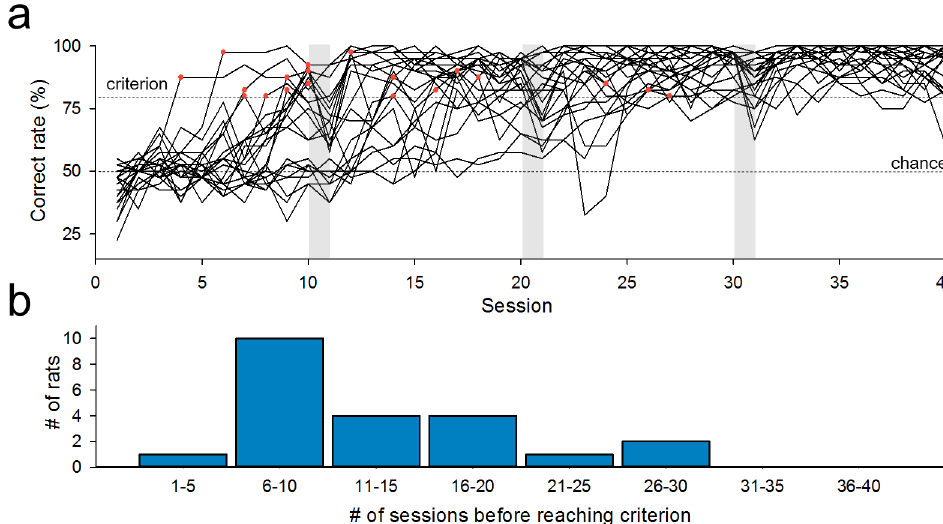
Fig 3. Individual differences in learning curves. (a) Time courses of the correct rates for 22 rats. Reaching the correct rate of 80% was defined as the criterion for completion of learning. Red dots indicate the first session in which the rats met the criterion. (b) Distribution of the sessions spent to reach the